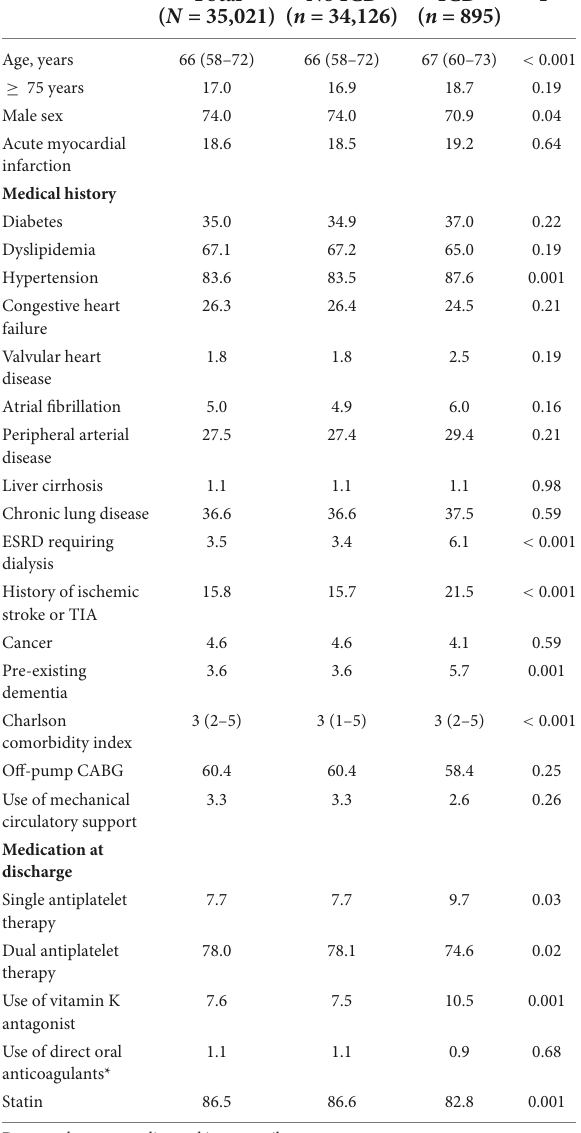
TABLE 1 Baseline characteristics of patients with or without intracranial